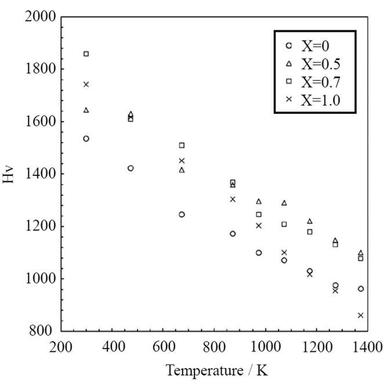
Vickers hardness of TiCXN1-X-TiCrNbMoTa composites as a function of temperature.